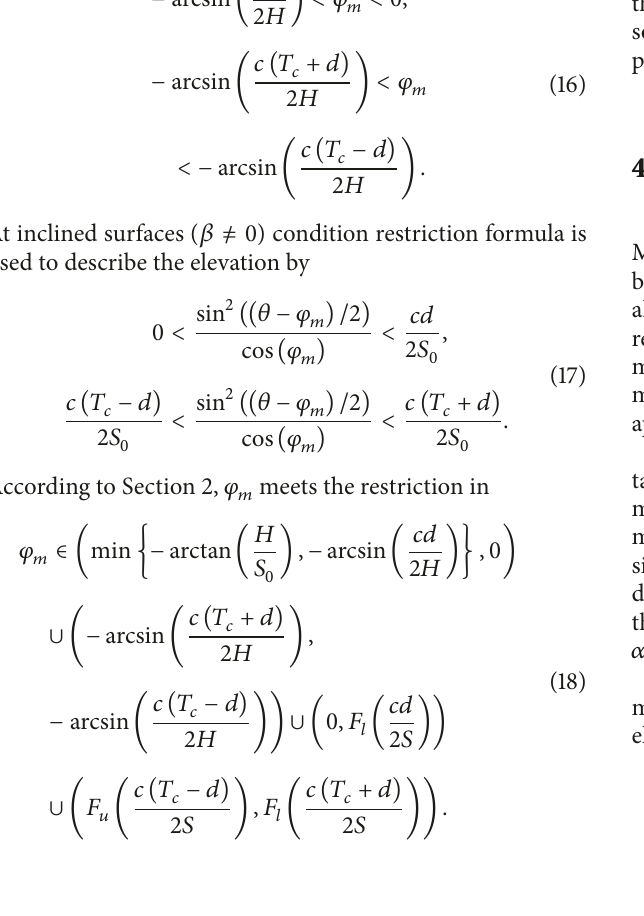
)/2)/ cos (𝜑 )) = 𝑟} ; 𝑚 𝑚 )/2)/ cos (𝜑 )) = 𝑟} . 𝑚 𝑚